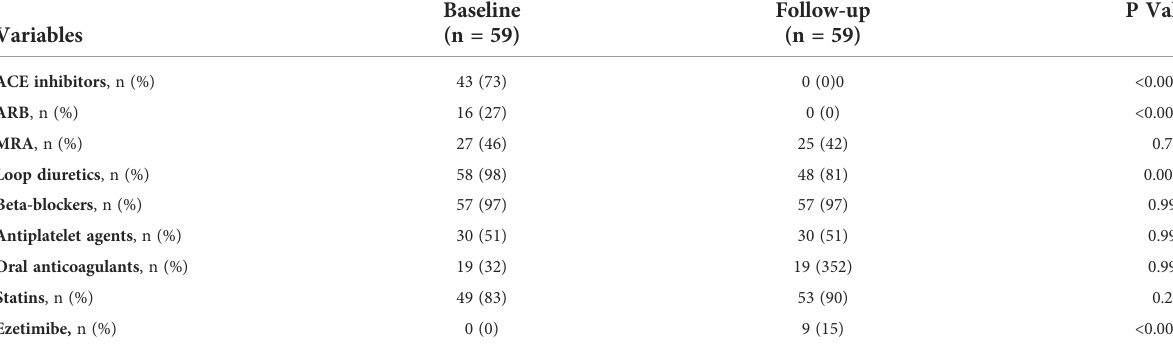
TABLE 5 Pharmacological treatments at baseline and after 24 weeks of therapy with